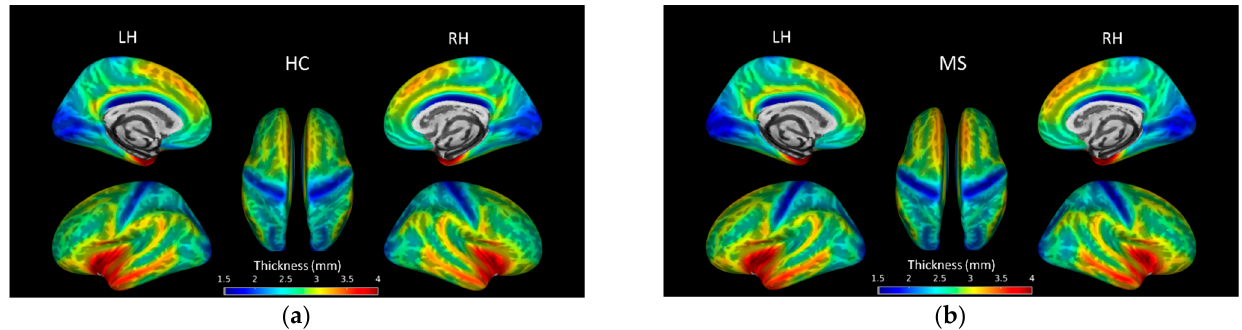
Figure 1. Lateral, medial and superior views of brain surface maps of mean cortical thickness (mm) in ( a ) healthy controls (HC), and ( b ) multiple sclerosis (MS) participants.